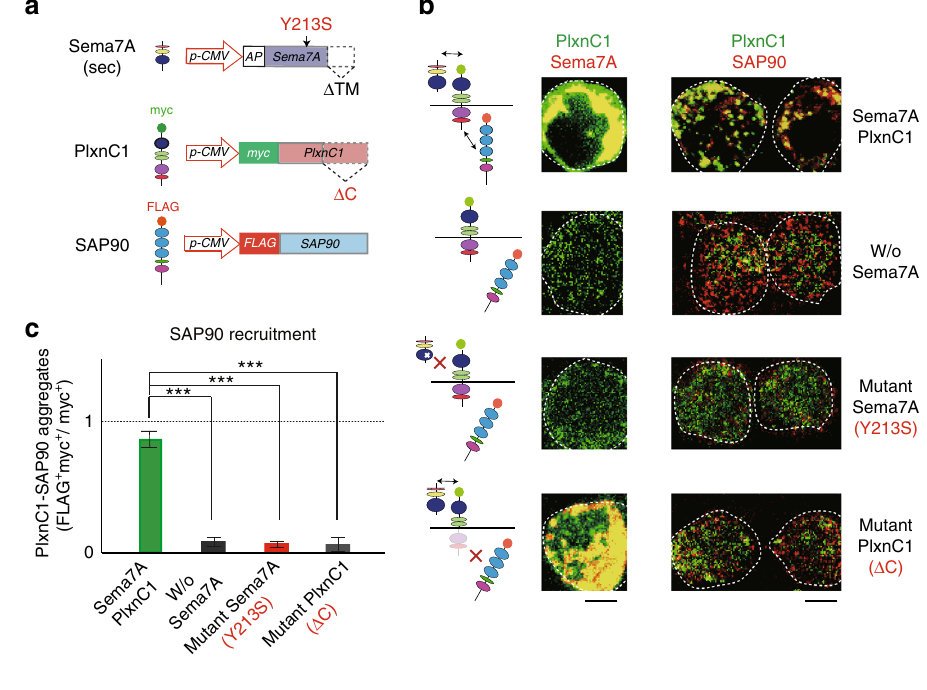
In Fig. 7b, the representative image of myc-PlxnC1/FLAG-SAP90 expressing cells treated with Sema7A Y213S was inadvertently replaced with an inverted duplicate of the image directly above, showing cells without Sema7A treatment. The correct version of Fig. 7